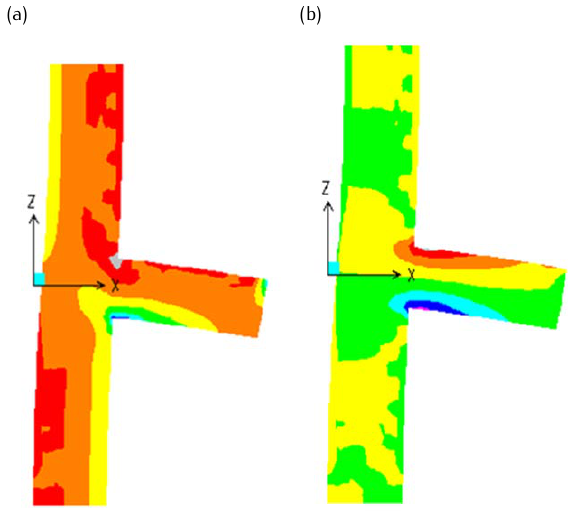
Figure 12. Typical ANSYS results (a) Control specimens; (b) GFRP